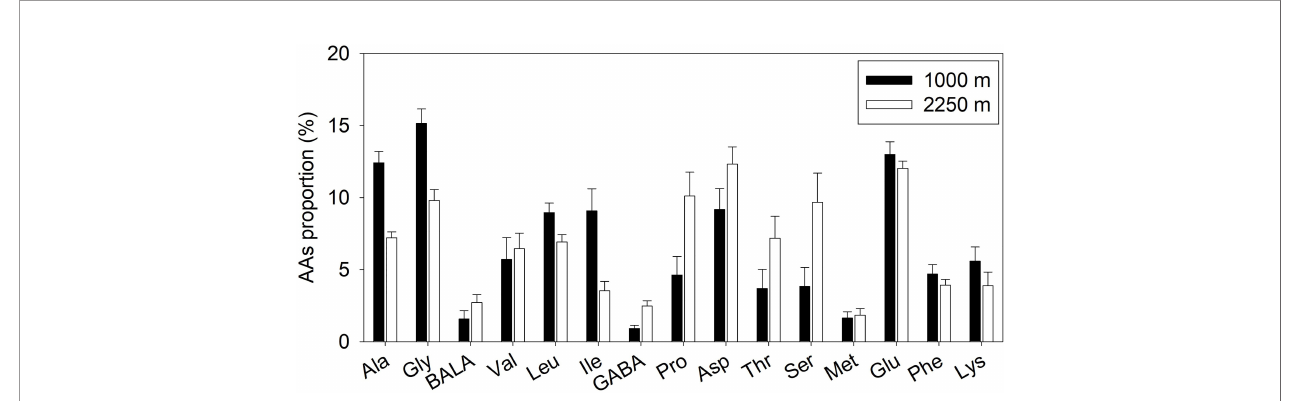
FIGURE 5 | Molar percentage of amino acids in sinking particles collected at depths of 1000 m and 2250